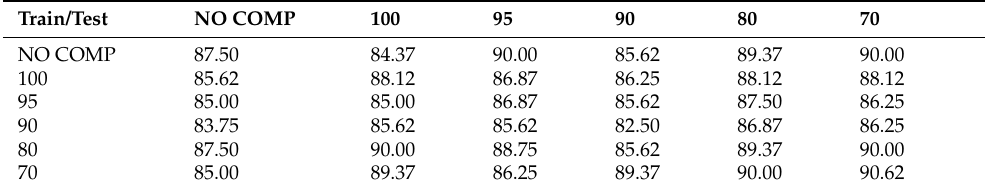
Figure 14. Examples of face images before (top row) and after (bottom row) the reconstruction when different resizing factors are applied as post-processing. Table 10. Accuracy obtained by LM 68 with different JPEG quality factors (reported in percentage).